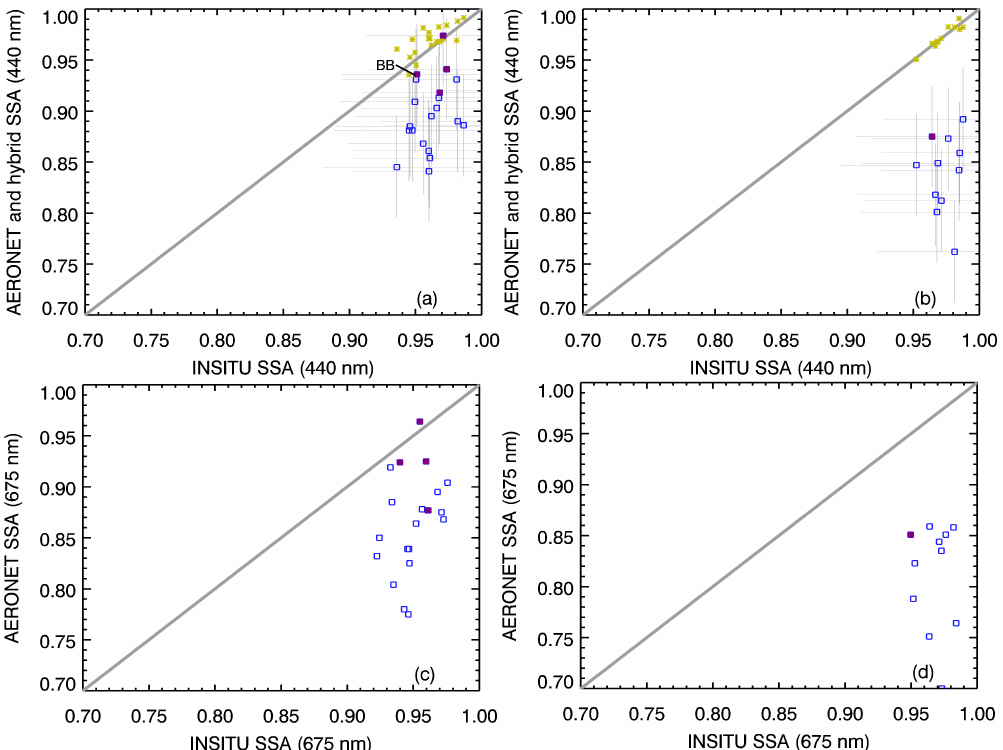
Figure 6. SSA comparison: (a) BND at 440nm, (b) SGP at 440nm, (c) BND at 675nm and (d) SGP at 675nm. Blue line is linear fit for all points shown; gray line is 1-to-1 line. Thin gray lines associated with each data point represent measurement uncertainties. Blue points show the average of all AERONET Level 1.5 AAOD retrievals for which there was a successful AERONET Level 2 almucantar retrieval within ± 3h of end of profile. Purple points indicate the few points for which there are AERONET Level 2 almucantar retrievals and where the average AERONET AOD 440 for those retrievals was great than 0.2. The yellow points represent the “hybrid SSA”, which utilizes the AERONET AOD and the in situ AAOD to derive SSA as described in the text. The in situ uncertainty lines here represent SSA uncertainty of 0.06, which is the worst-case